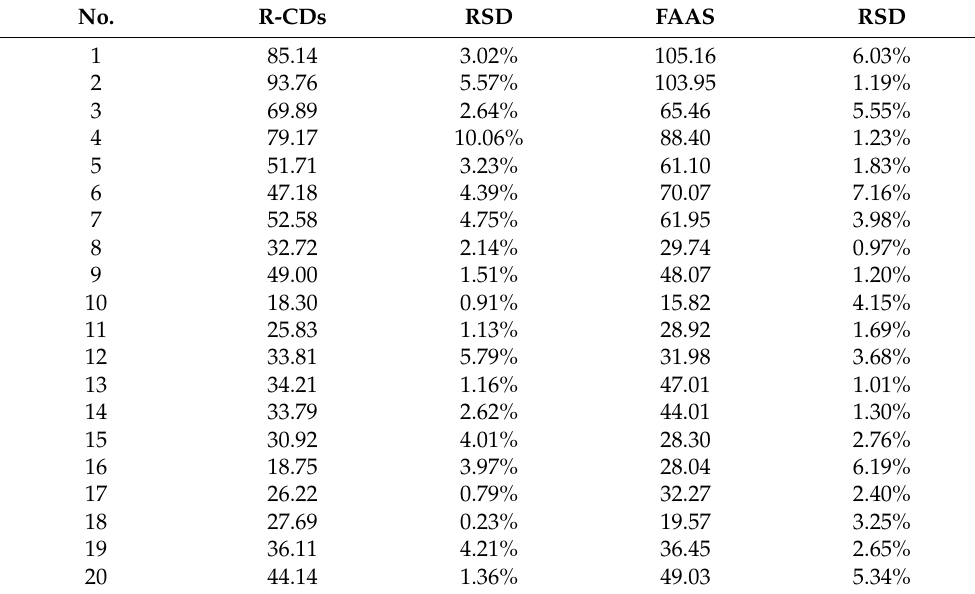
Table 4. Comparison of Zn 2+ content in samples detected by two methods.